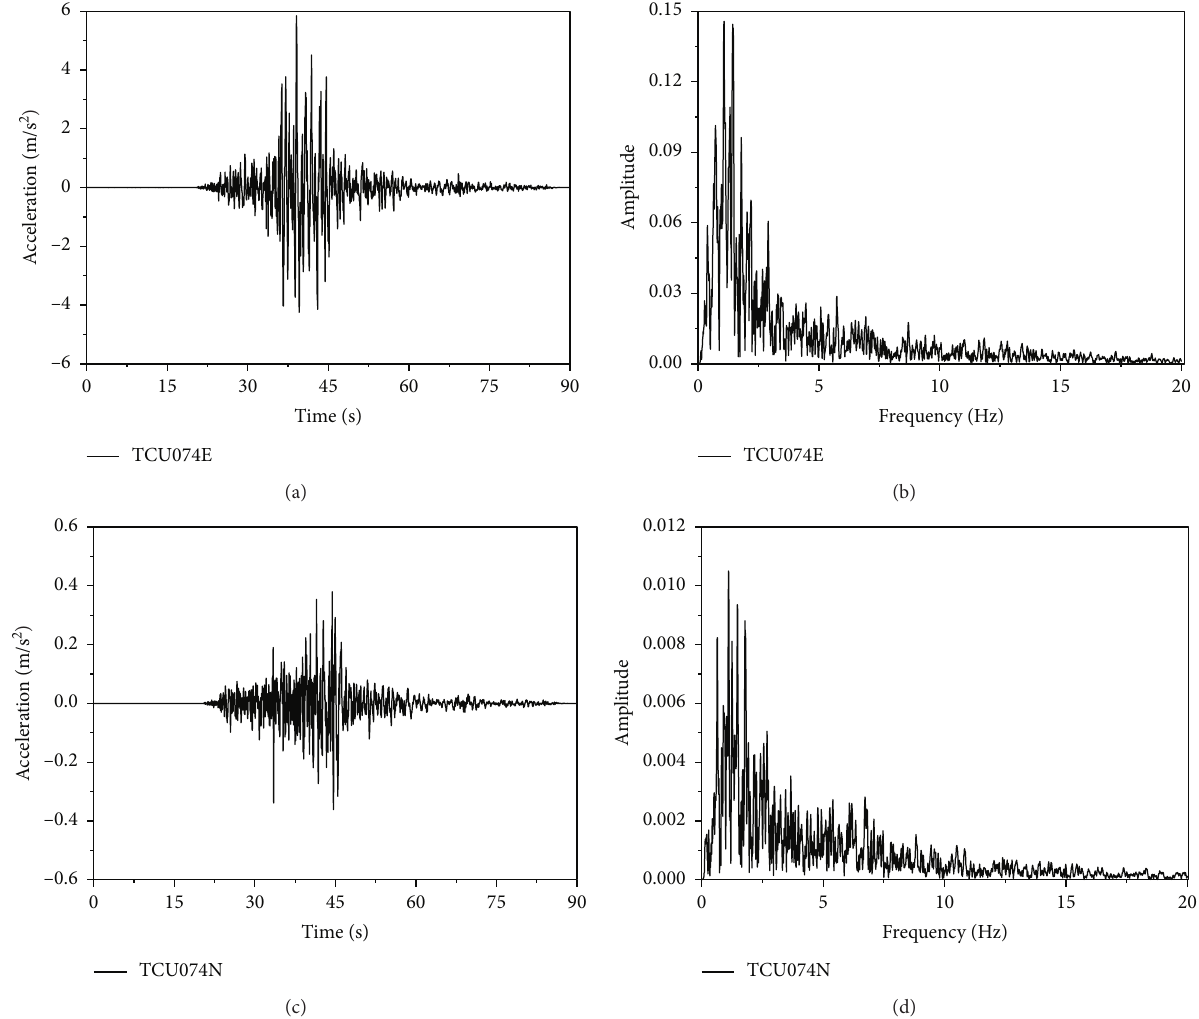
Figure 16: (a) The acceleration time-history of horizontal component ground motion; (b) the corresponding Fourier spectra of horizontal component ground motion; (c) the acceleration time-history of parallel component ground motion; (d) the corresponding Fourier spectra of parallel component ground motion.